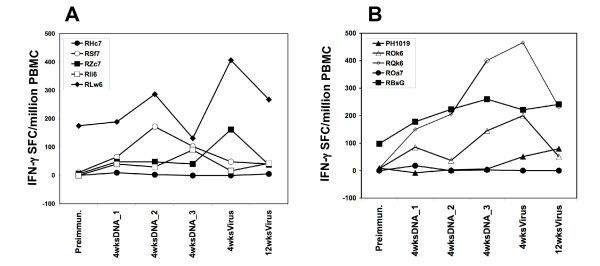
Magnitude of PfCSP-specific IFN-γ responses from PfCSP/PBS and CSLAM/PBS immunized animals. PBMC were collected at time points as defined in the legend to Figure 2 and assayed against recombinant PfCSP protein by IFN-γ ELIspot. Results show the magnitude of SFC from individual monkeys immunized with either (A) PfCSP/PBS or (B) CSLAM/PBS.